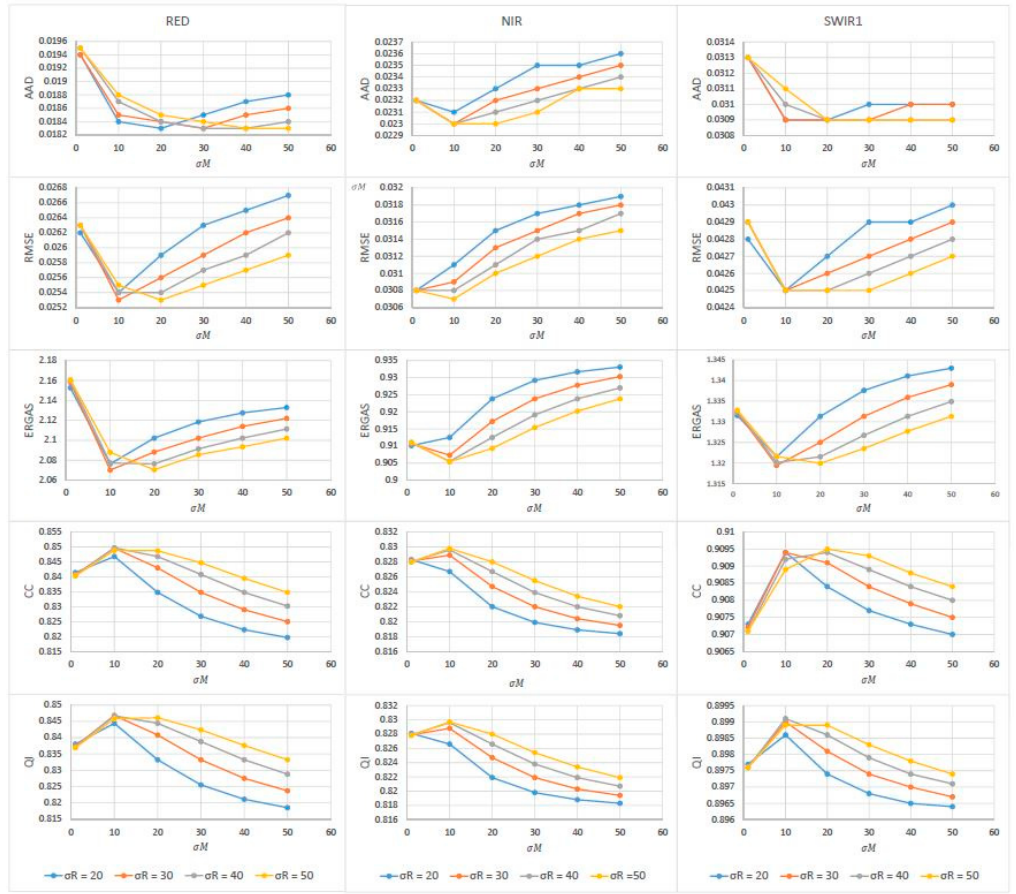
Figure 6. Quality indices comparison of the predicted Landsat-like images by PSRFM with different priori uncertainties set ranged from 20 to 50 and from 1 to 50 for the input Landsat and MODIS images, respectively. The different colors represent the priori uncertainties used for the input Landsat images σ R . The graphic curves represent changes of quality indices with different priori uncertainties ( σ M ) used for the input MODIS images. The columns present the three bands RED, NIR and SWIR1, respectively.